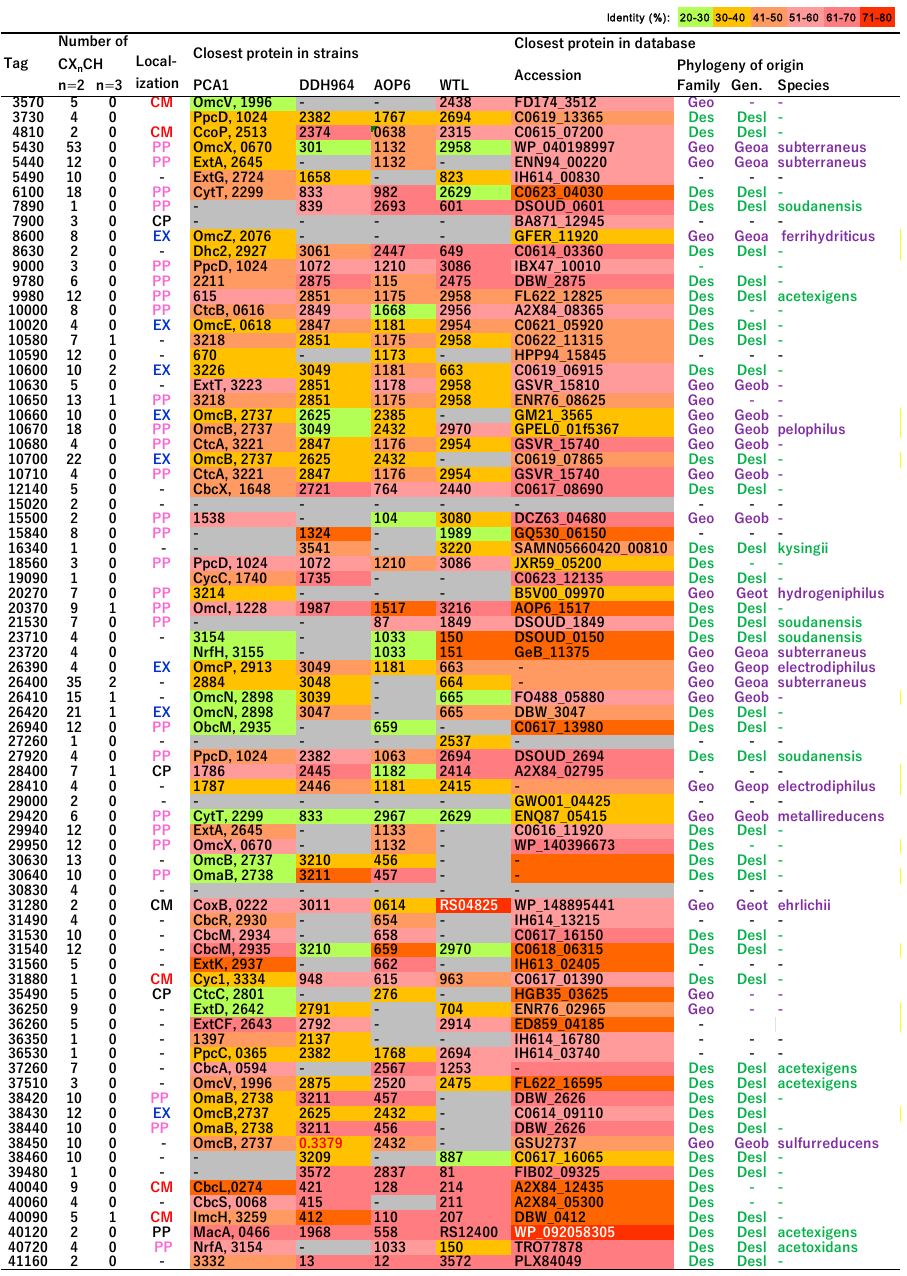
Figure 5 . List of putative c -type cytochrome C proteins present in the NIT-T3 genome. Tag indicates the locus tag of the coding sequence encoding c -type cytochromes in the genome. CM, cytoplasmic membrane; PP, periplasm; EX, extracellular; (-), unknown. The number and color scale for the closest protein in the strain indicates the locus tag and amino acid identity (%), respectively. Geo, Geobacteraceae ; Geoa, Geoalkalibacter ; Geob, Geobacter; Geop; Geopsychrobacter; Geot , Geothermobacter; Syn, Syntrophotaleaceae; Synt, Syntrophotalea; Des, Desulfuromonadaceae; Desl, Desulfuromonas.